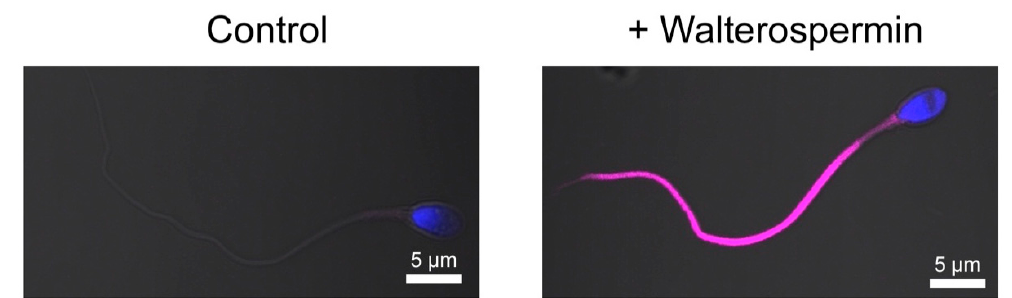
Figure 13. Specific labeling of human sperm flagellum by the fluorescent analog Cy5-walterospermin. Control sperm ( left ) and sperm incubated with fluorescent Cy5-walterospermin ( right ) were fixed and fluorescence was assessed by confocal microscopy. Fluorescent walterospermin signal was found to be located at the surface of the flagellum and not on the head.